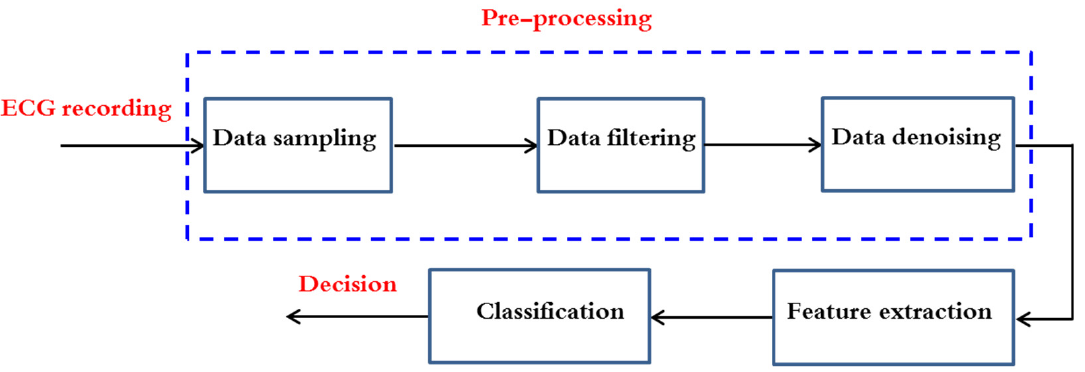
Figure 1. ECG classification flow chart analysis.